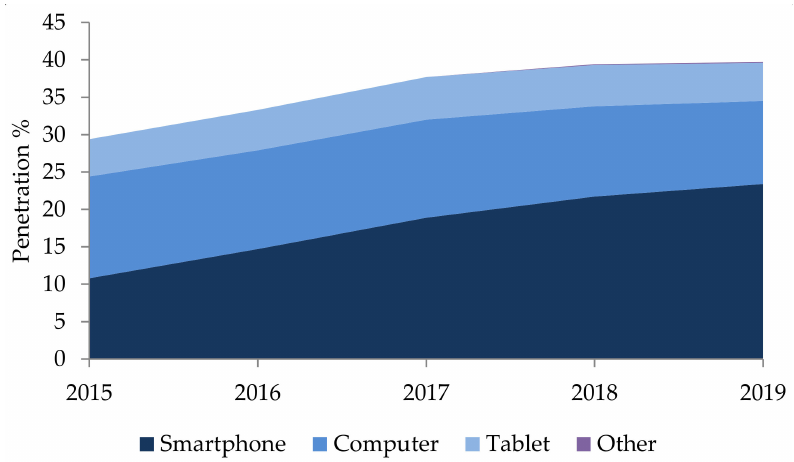
Figure 6. Evolution of newspaper audiences by format device (Penetration %). Compiled by the authors on the basis AIMC (2020) [41]